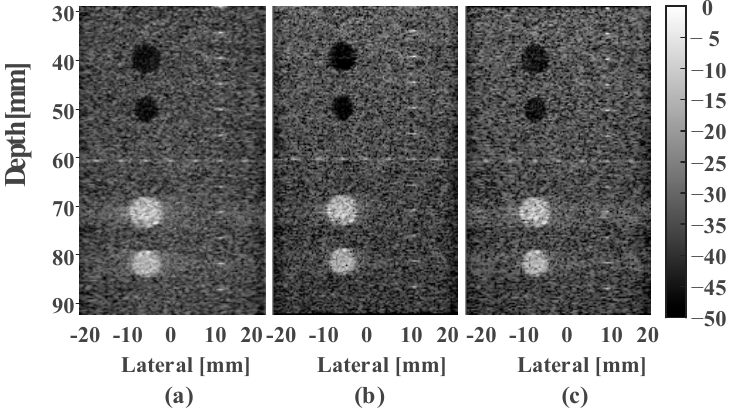
Figure 5. Simulated images by ( a ) DAS, ( b ) fk and ( c ) fkCS with 80% compression rate with hypoechoic, bright region and point scatterers.